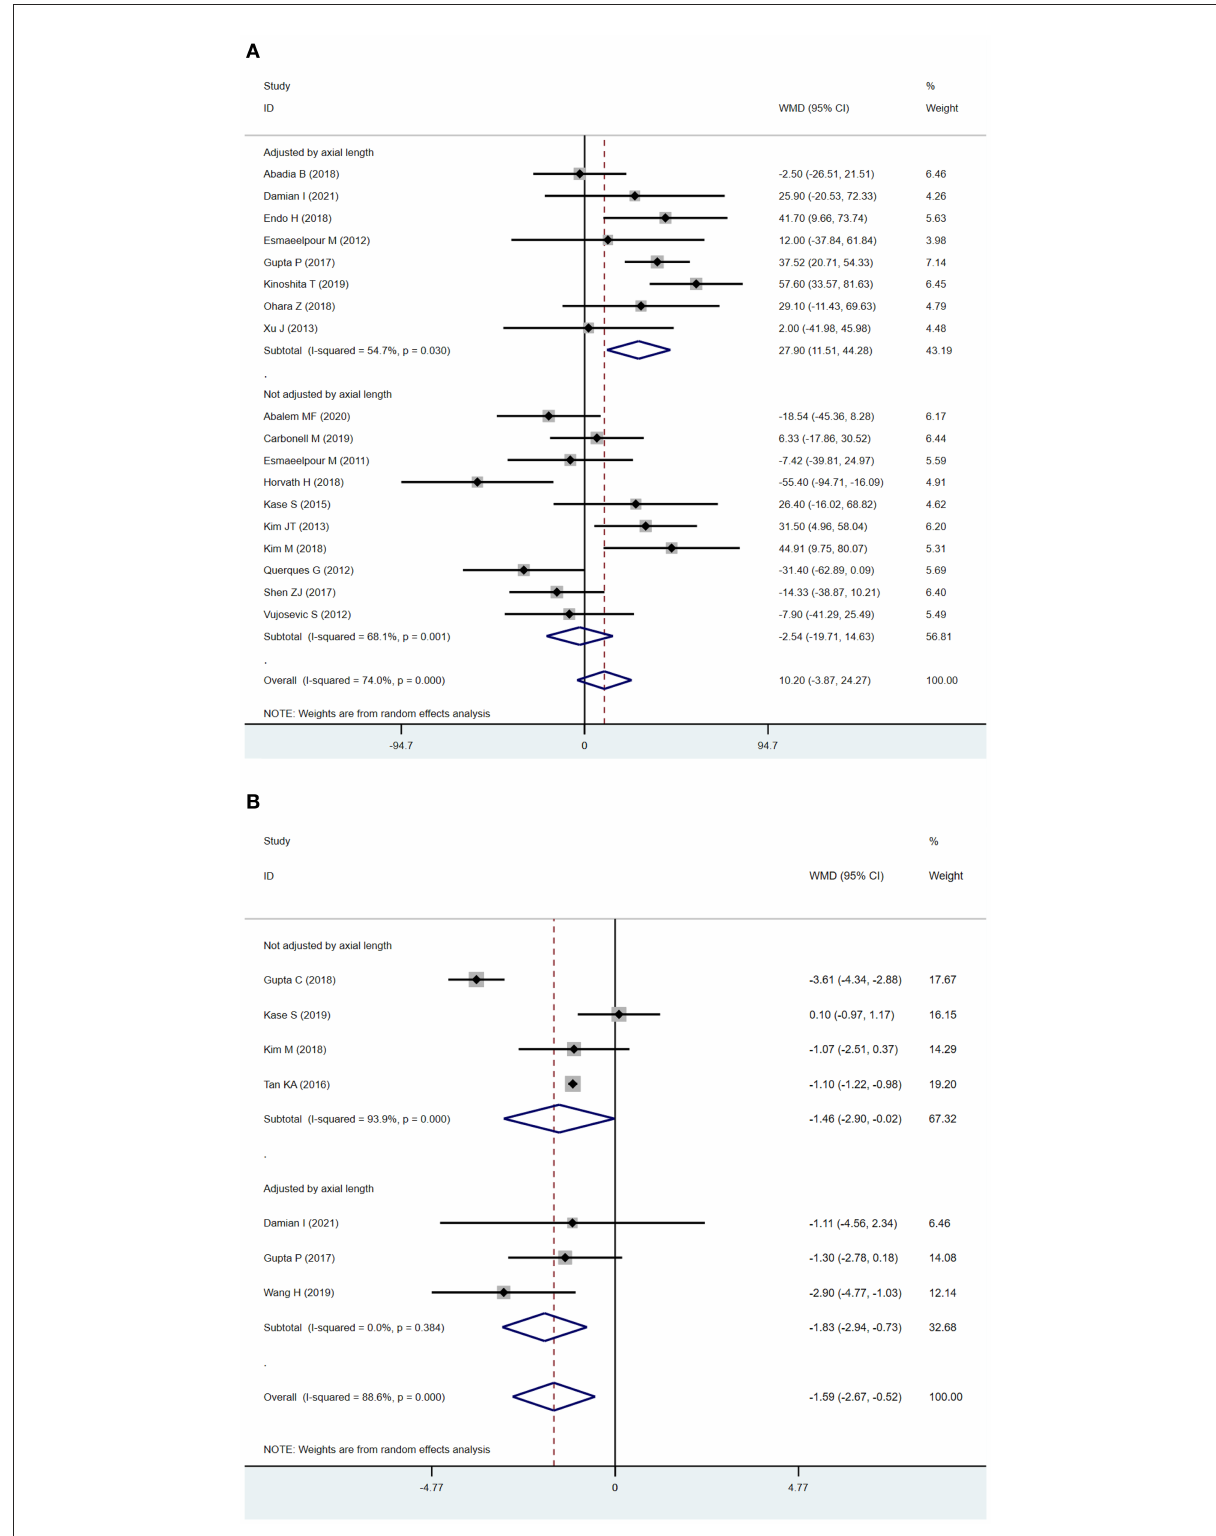
FIGURE3 Sub-analysis of subfoveal choroidal thickness (SFCT) and choroidal vascularity index (CVI) according to the adjustment of axial length (A) . SFCT (B)